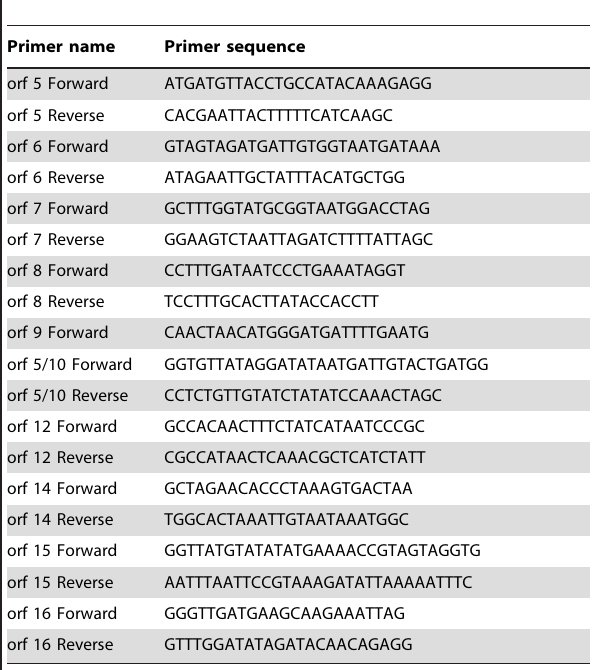
Table 3. Primers used for LOS biosynthesis cluster